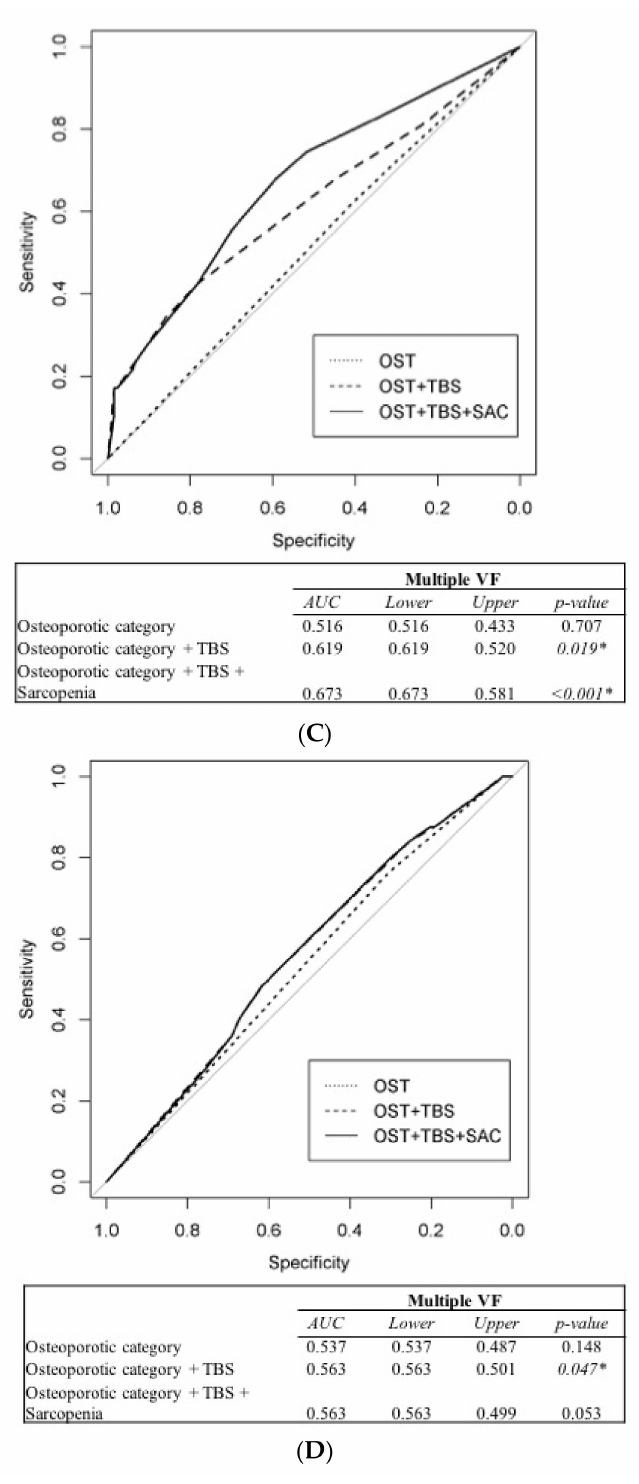
Figure 1. Area under curve (AUC) values for any vertebral fracture (VF) for ( A ) males and ( B ) females, and for multiple VFs for ( C ) males and ( D ) females. OST: osteoporotic category, TBS: trabecular bone score, SAC: sarcopenia. * Significant p